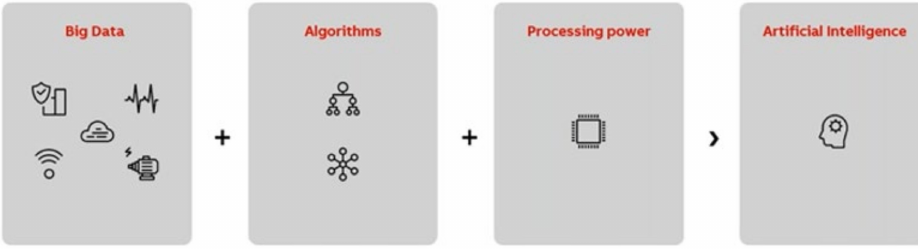
Figure 2. Digital technologies are reviving AI advances—Processing power lifts big data and algo- rithms to the next level of Artificial Intelligence.